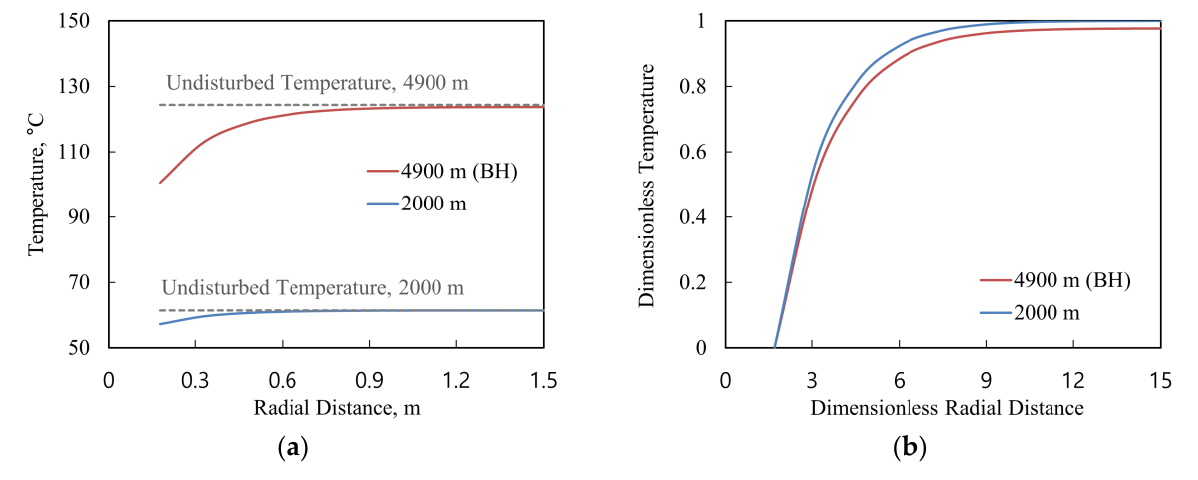
Figure 5. Radial temperature distributions of different depths: ( a ) radial temperature distribution and ( b ) dimensionless radial temperature distribution.